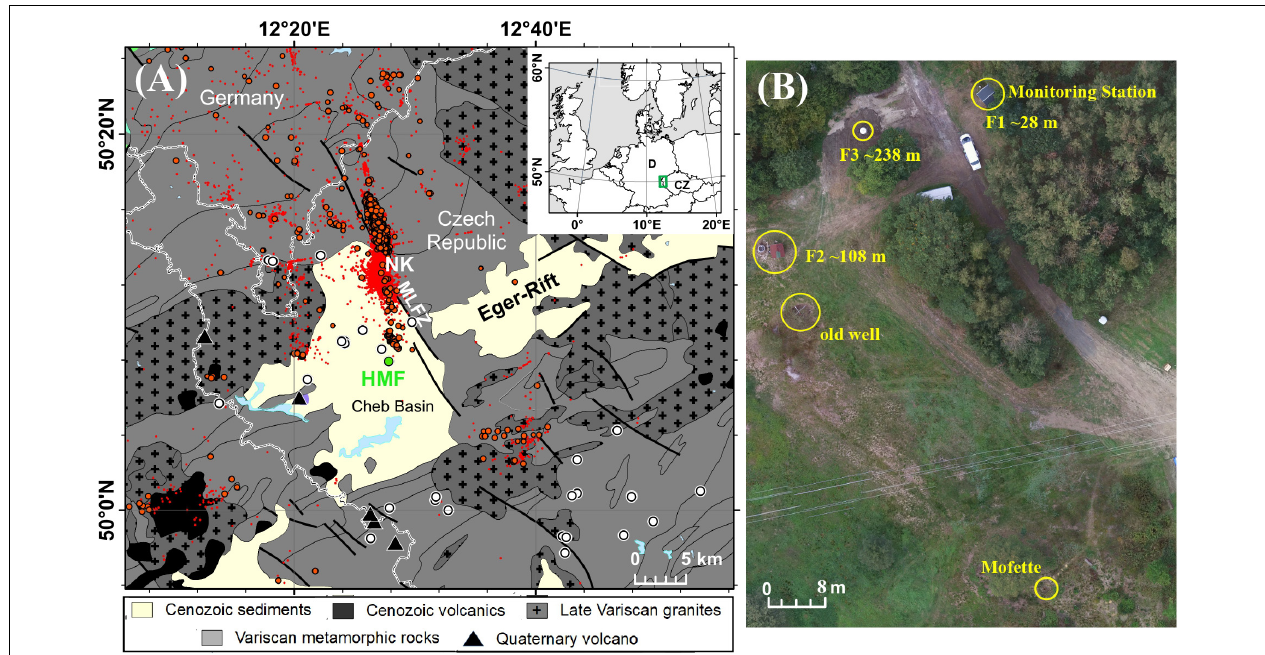
FIGURE 1 | (A) Simplified geological map of the Eger Rift area and its surroundings [“Geological Map of Germany 1:1 000 000 (GK1000),” BGR]. The Hartoušov Mofette Field (HMF) is indicated with a green circle. The white circles correspond to mofettes and springs with CO 2 gas flux > 400 l/h, while the red circles portray the seismic activity during the past 30 years. The Mariánské Láznˇe Fault Zone (MLFZ), as well as the Nový Kostel focal zone (NK), are also shown. (B) Orthomosaic image of the HMF, where the positions of the 3 boreholes (F1, F2, and F3) along with their depths, the mofette, and the old well are indicated. A seismological and geochemical monitoring station located at F1 is also marked on the